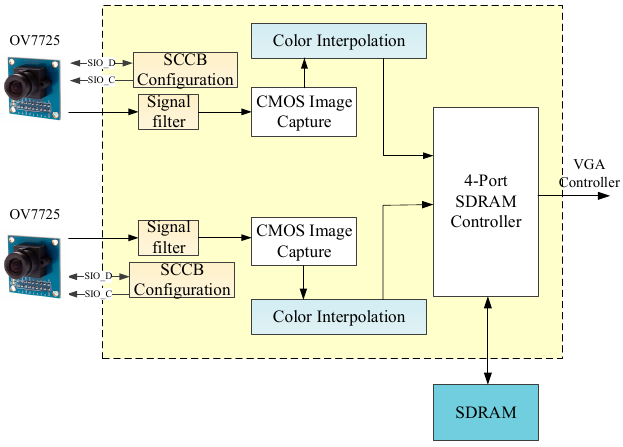
Figure 3. Dual camera vision module.